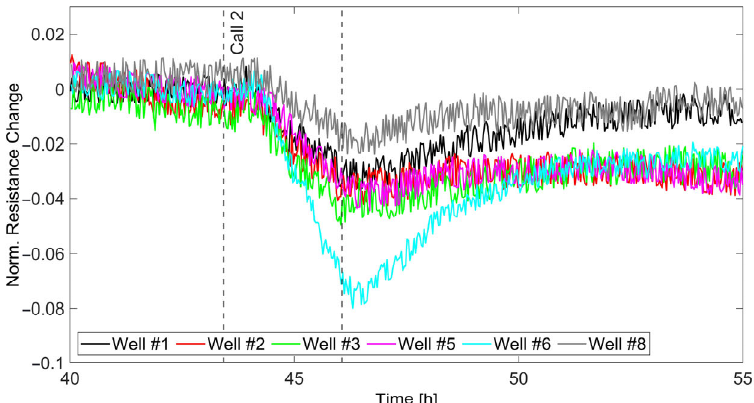
Figure 12. Measurement results of impedance for f = 500 Hz in normalized values for 6 wells (without #4 and #7). Well #1 (not containing cells) is shown in black. The dashed line marks the start and end of the phone call.